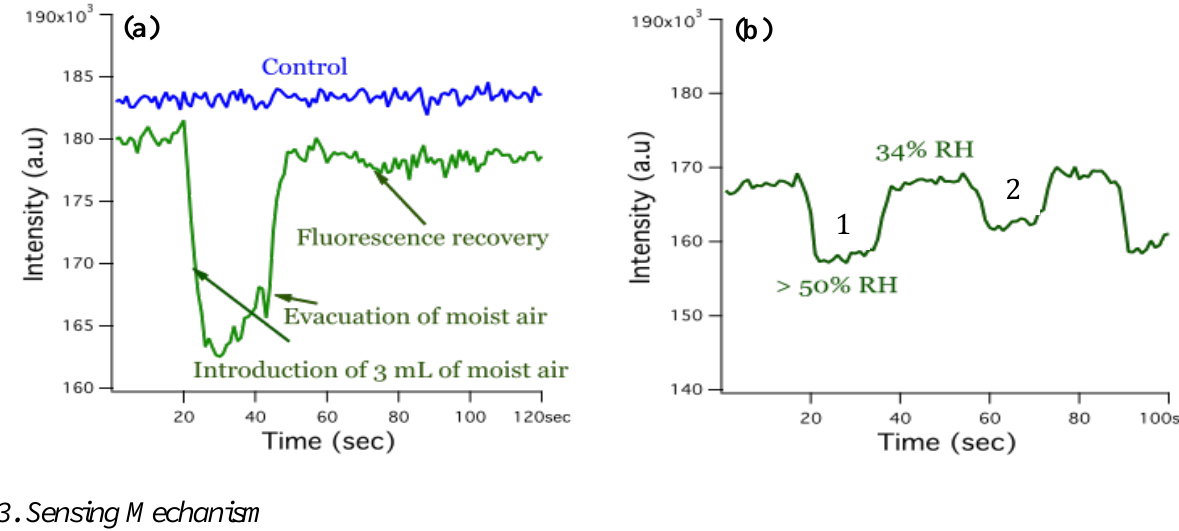
Figure 7. Plot of the magnitude change of the intensity of the band edge emission at λ = 523 when humid air is injected into the cuvette. (a) The plot on the right (b) illustrates the repeatability and volume sensitivity of the sensor’s response. In plot b, curve 1 represents two mL of moist air and curve 2 represents one mL of moist